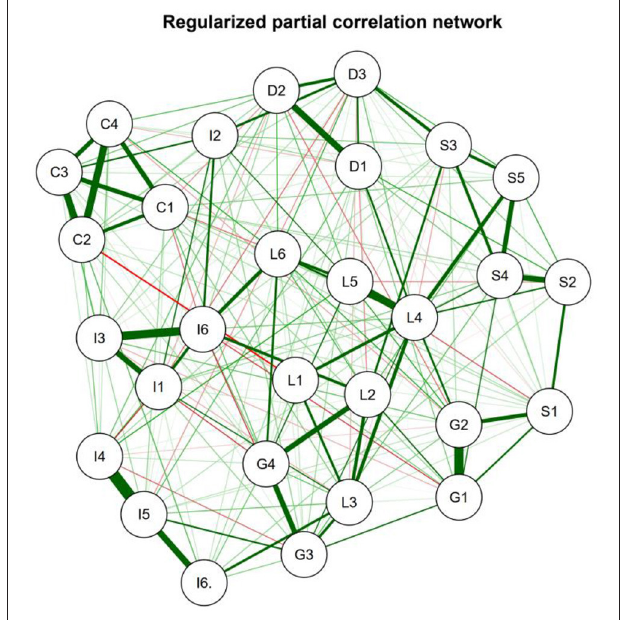
FIGURE 1 | Regularized partial correlation network of the SQAE